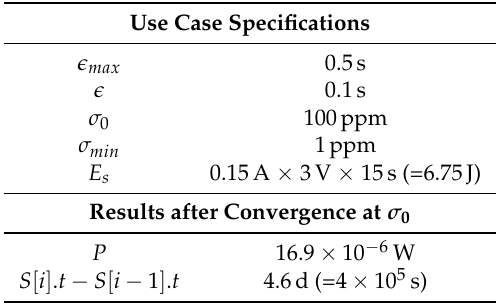
Table 1. Operational parameters for a use case: on top the values from the use case specifications, below the expected performance. Use case specifications are appropriate for a quartz crystal resonator with a wide frequency